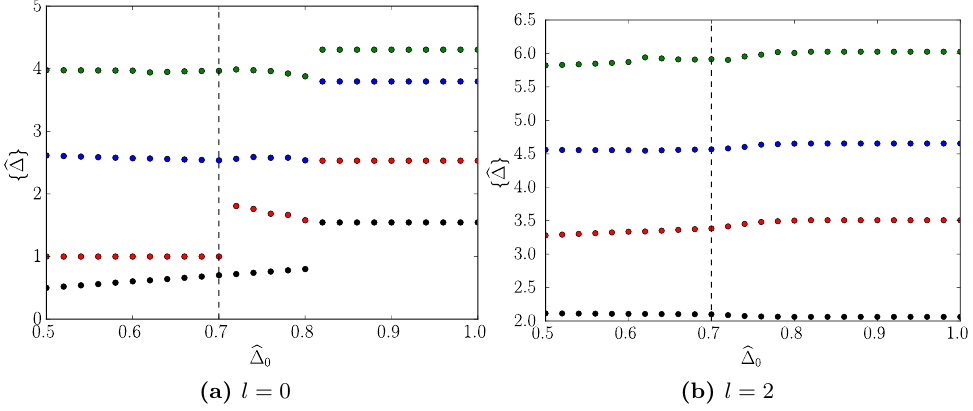
= − 0 . 2 . For each value of the imposed Figure 10. Spectra in the vicinity of the exotic kink for a φ 2 scalar gap b ∆ , we plot the dimensions of the first four operators of spins 0 and 2 for the solutions 0 which maximize the gap b ∆ . The location of the kink itself is indicated with a vertical dotted 2